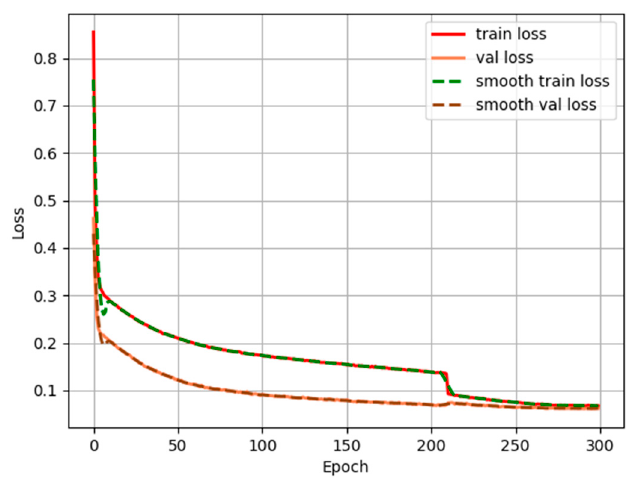
Figure 8. Loss value change curve.